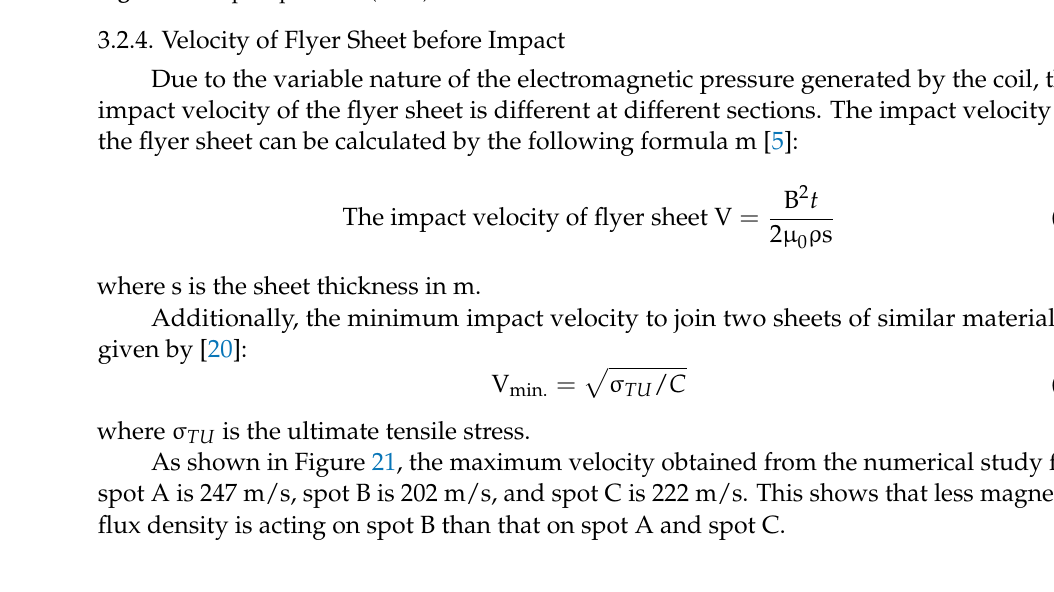
Figure 20. Impact pressure (MPa) at the interface.